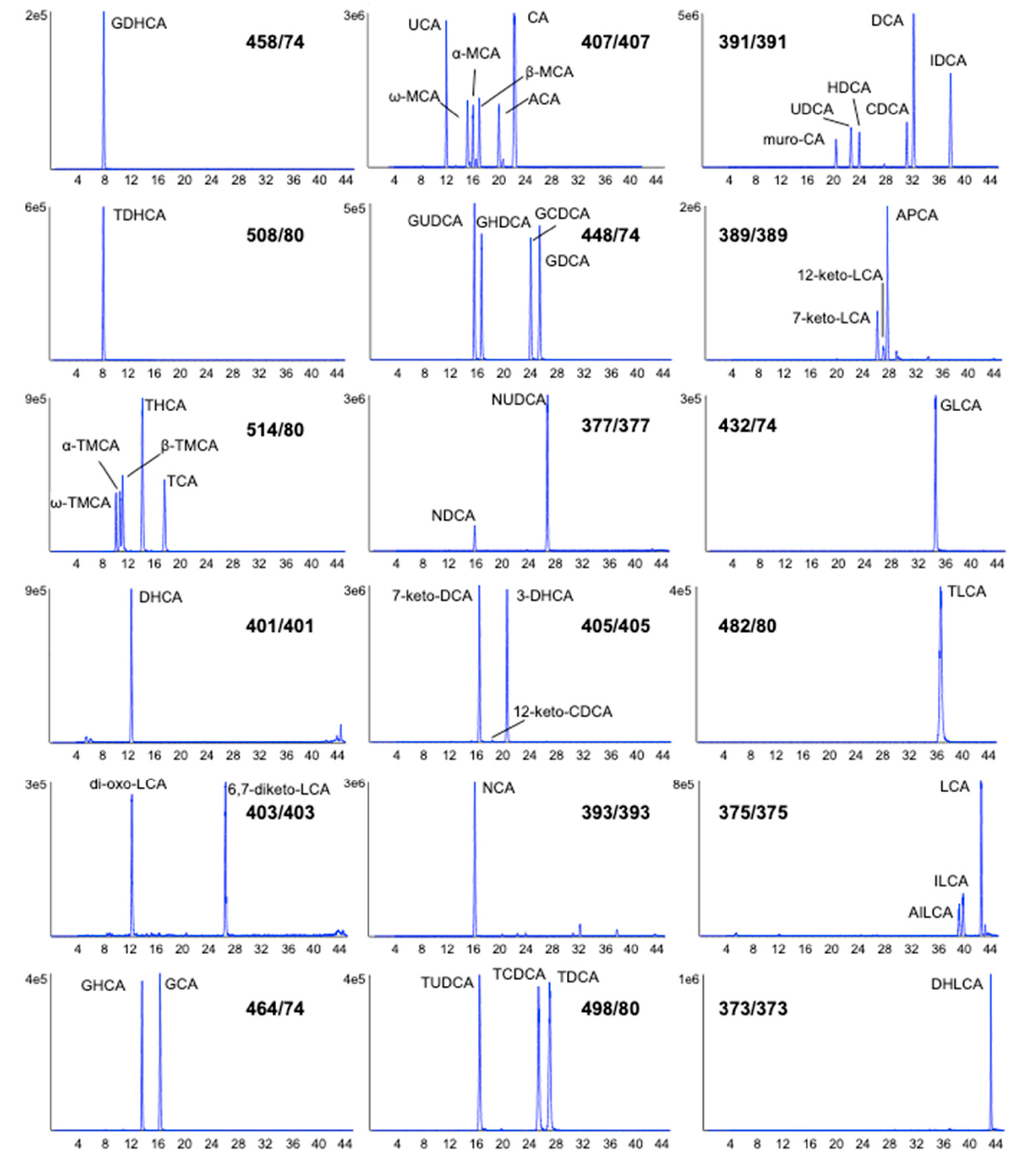
Figure 1. Representative LC-MRM chromatograms in negative mode of a standard mixture containing 46 bile acids (using the most sensitive transition for each bile acid, as shown). Acronyms for each bile acid species are listed in the Abbreviations (and Methods) section.